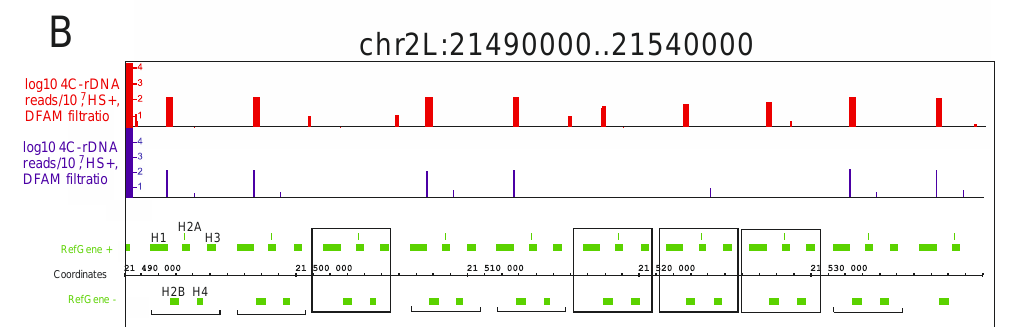
Figure 2. rDNA-contacting sites inside histone gene clusters. ( A ) rDNA contacts are shown in the IGB Browser for the mapped reads without Dfam filtering and after the filtering. The contacts in the normal and heat-treated cells are shown in blue and red, respectively. The distribution of natural transposable elements and small RNAs are indicated as in the FlyBase Browser. The intra-chromosomal contacts detected in Kc 167 cells are shown as in the WashU EpiGenome Browser (https: // epgg-test.wustl.edu / browser / ). ( B ) The rDNA contacts inside a 50-kb region of the histone gene cluster are shown in more detail. Two sets of histone repeats are indicated by brackets (the contacts detected in both HS − and HS + cells) or by frames (the contacts detected only in HS +